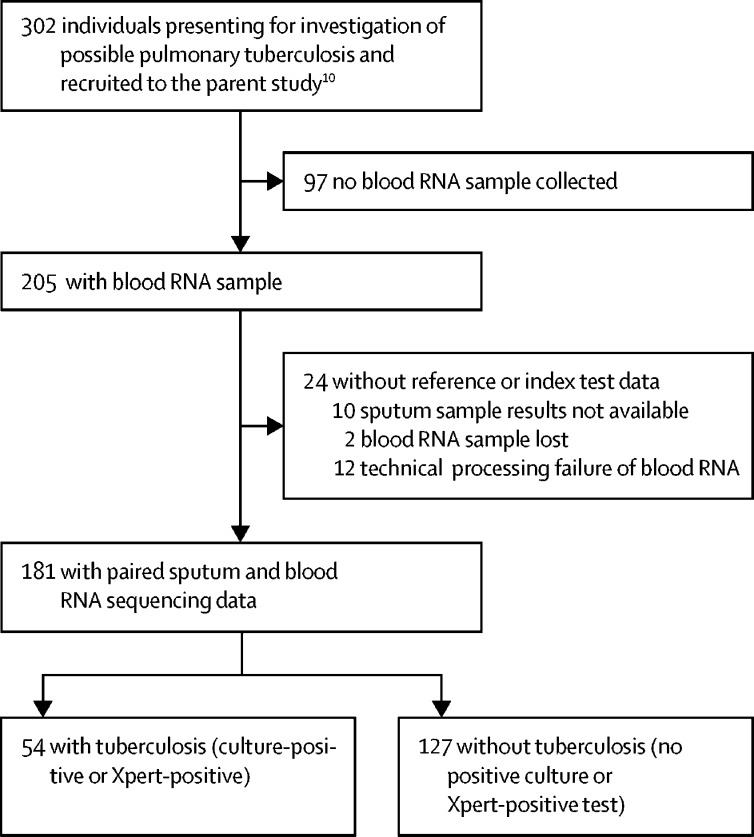
Study flowchart